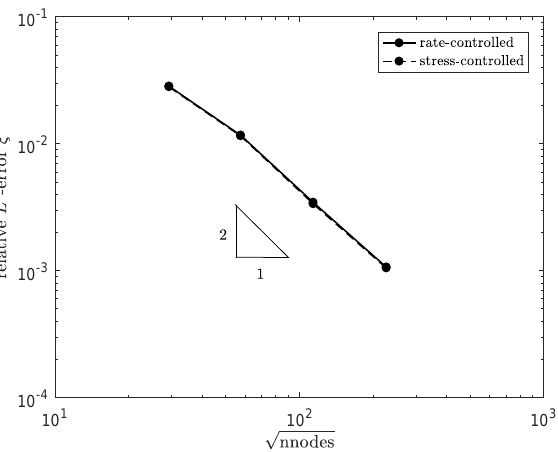
Figure 4. Relative error in ξ at the outlet of the channel for 2D meshes with different element sizes.